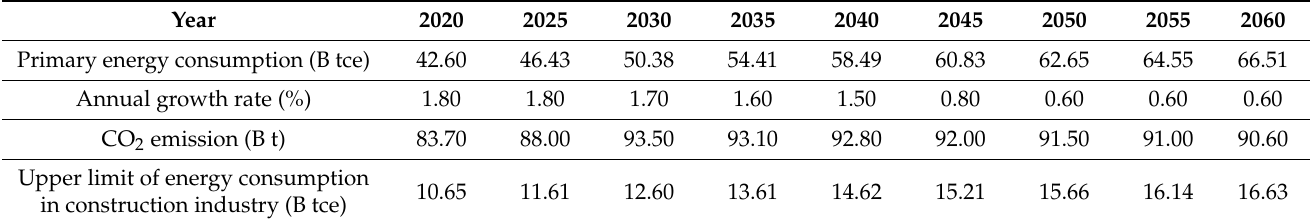
Table 6. China’s primary energy consumption in